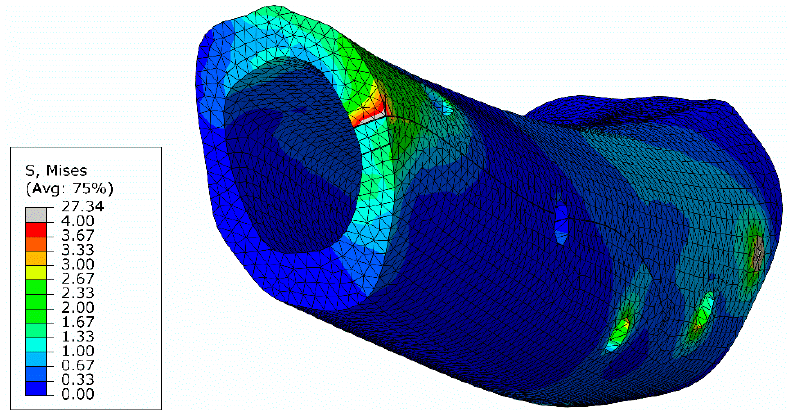
Figure 18. Stresses distribution (MPa) at the lag screw and at the oblique fracture surface.